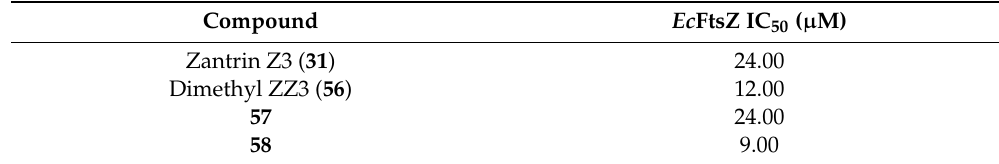
Figure 11. Chemical structures of dimethyl ZZ3 ( 56 ), quinazoline 57 and benzoquinazoline 58 . Table 11. IC 50 values of quinazolines and related compounds.